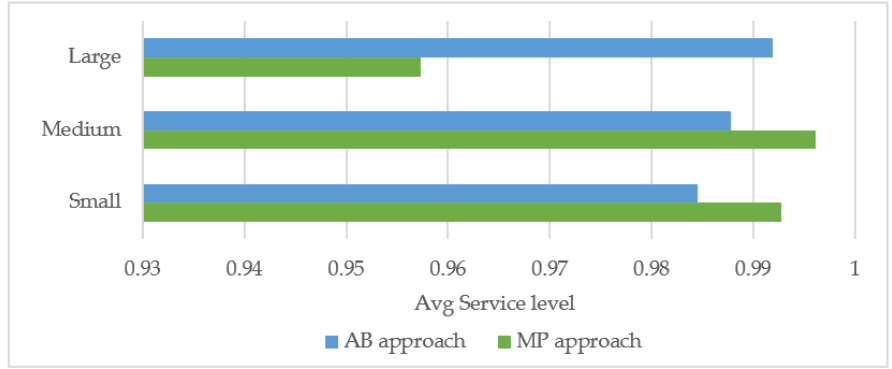
Figure 4. Average service level for small, medium, and large instances for MP and AP approach.